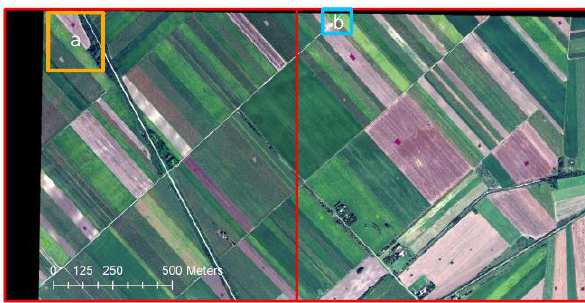
Figure 5. MAXAR image of Novi Sad test site and the tiles used for classification, training polygons and location. The tile numbers are: tile_0 (left) and tile_1 (right).